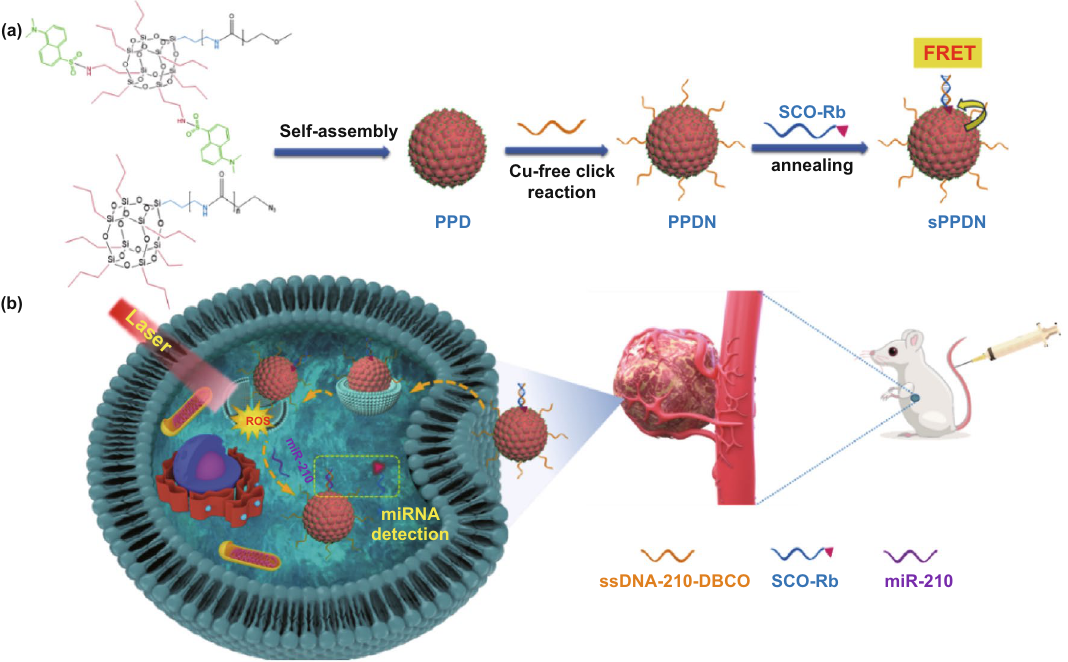
ton migration pathways. b The light-triggerable nuclear lysosomal escape strategy using sPPDN in